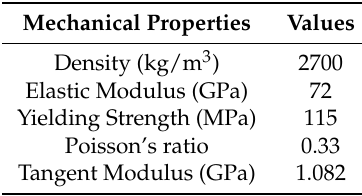
Figure 4. Experimental setup for the test and the mesh of the model. Table 1. Mechanical properties of the aluminum used in our analysis. The values were taken after a general survey on reference